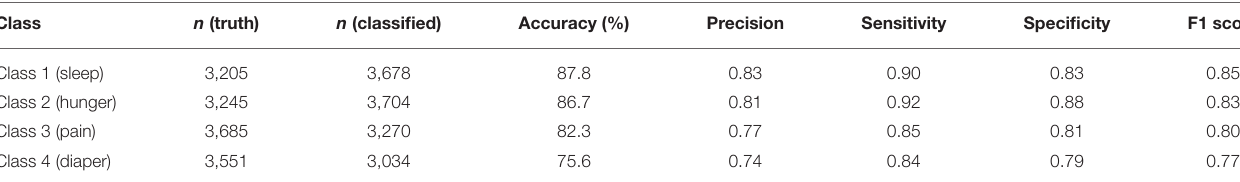
TABLE 14 | Evaluation metrics for the YOLOv4